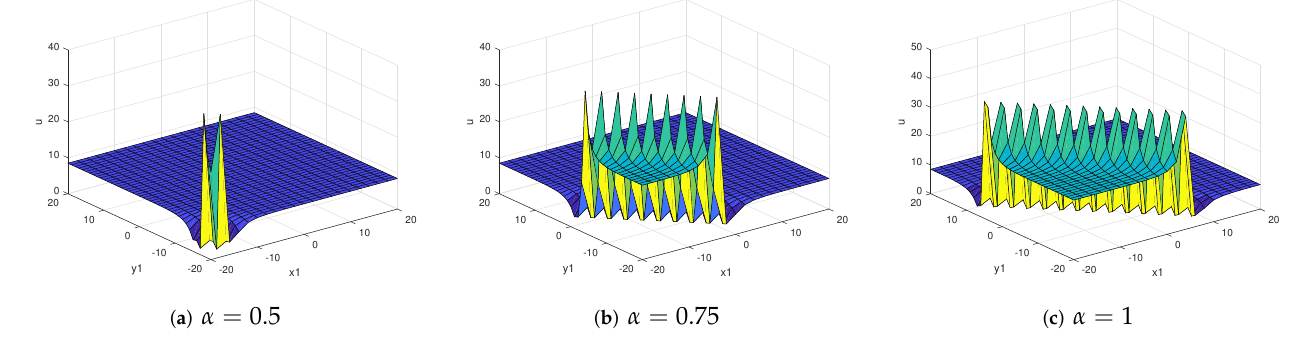
Figure 2. Exact solutions in Equation (53) for different α with α 1 = 1, β = 0.5, γ = 1, δ = 0.5, λ = 1.5, µ = 0.5, ε = 85.746, a 0 = 1, c 1 = 1, c 2 = 2, x 2 = 4, y 2 = 4, t =